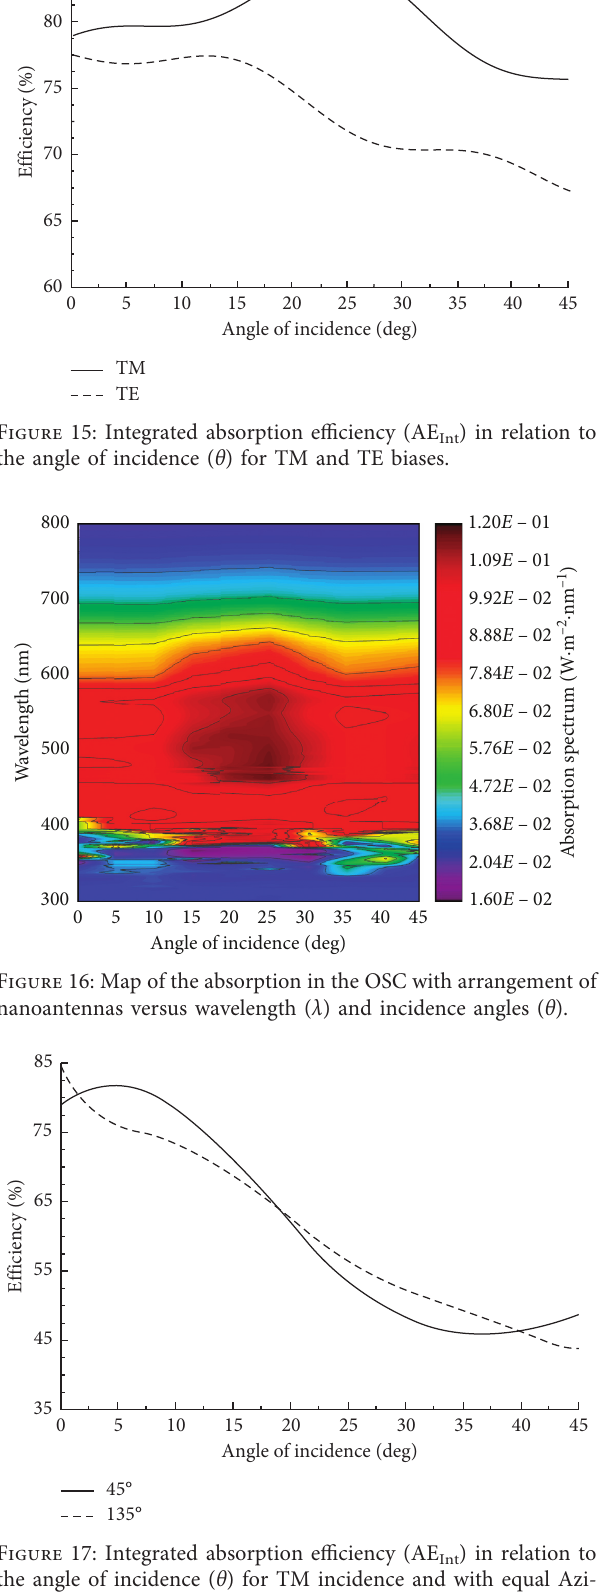
Figure 14: Absorption efficiencies of OSC as a function of pyramid top.